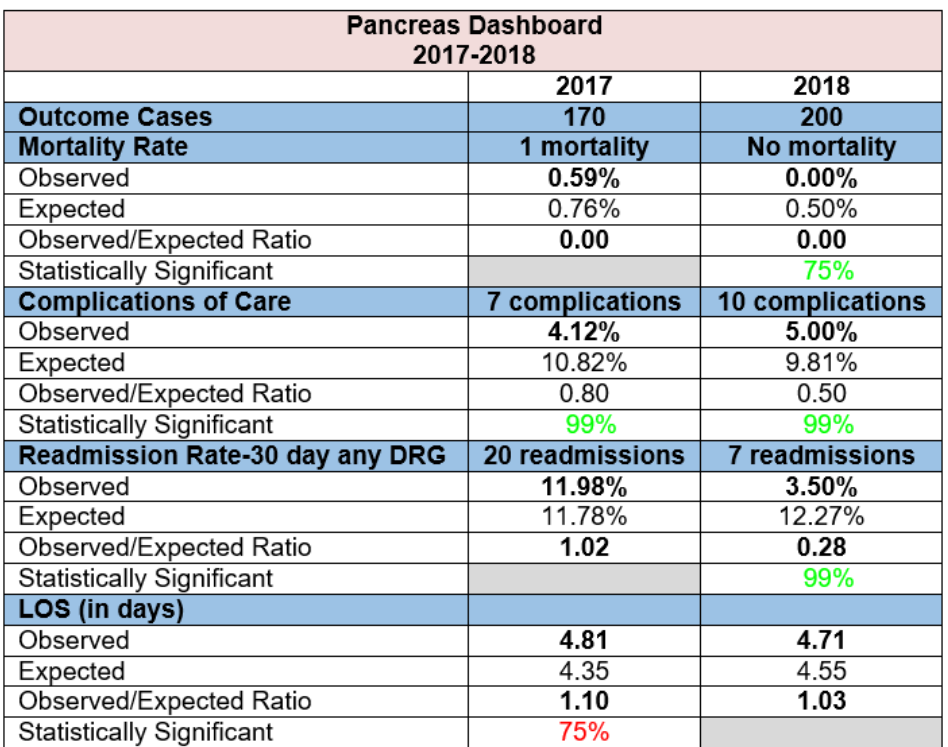
Figure 5. Example dashboard of clinical outcomes. Note: Green numbers represent the outcome’s variance is statistically better than expected; red numbers represent the outcome’s variance is statistically worse than expected; a grey box represents no statistical significance.